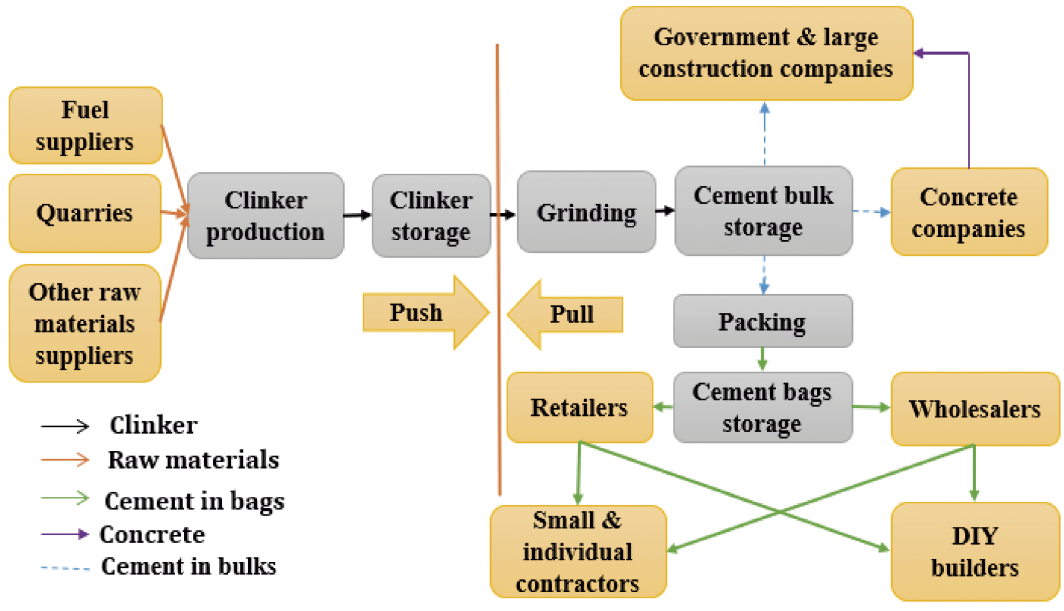
Figure 3. Build-to-Stock model (Agudelo,